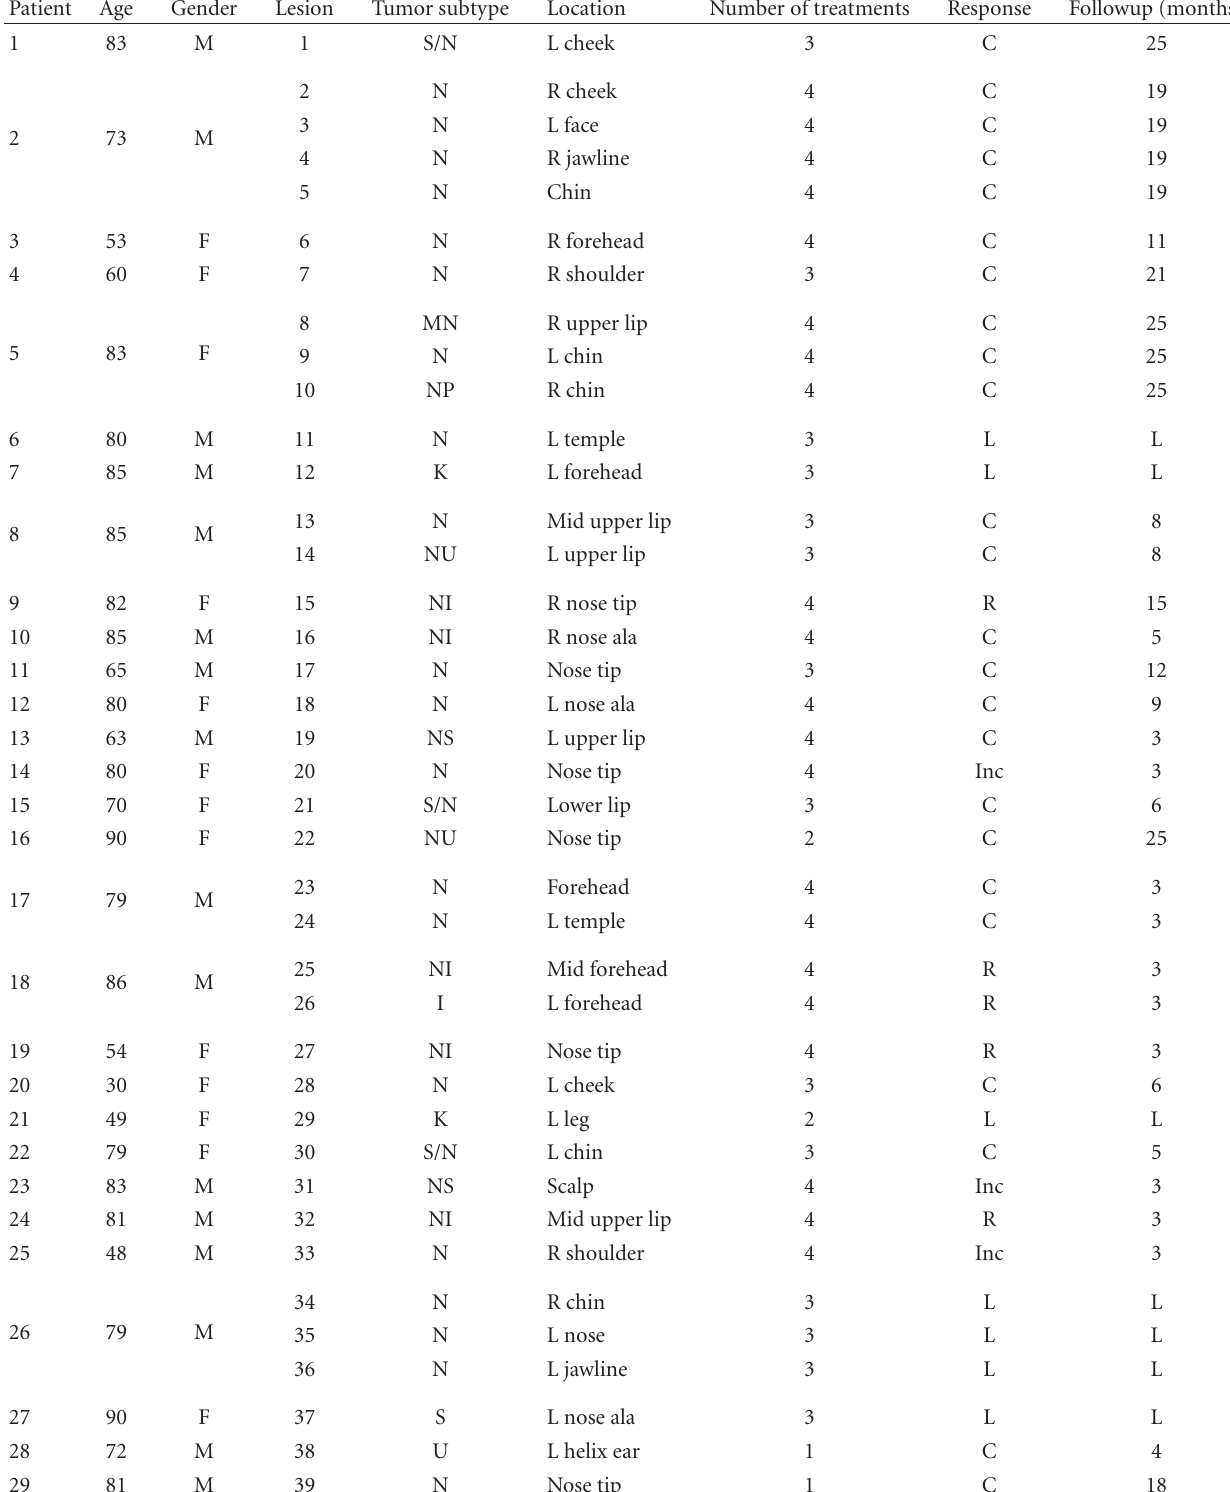
Table 1: Basal cell carcinoma and response to pulsed dye